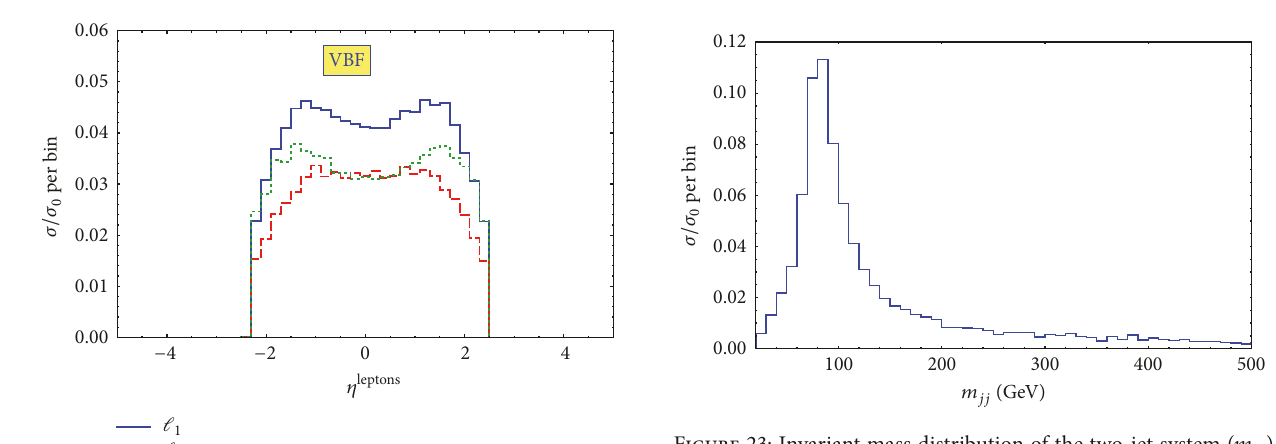
Figure 23: Invariant mass distribution of the two-jet system (𝑚 𝑗𝑗 ) from the ℓ + MET + 2𝑗 final state coming from ggF process. The two-jet system shows a peak around the 𝑊 mass (𝑚 𝑊 ) .